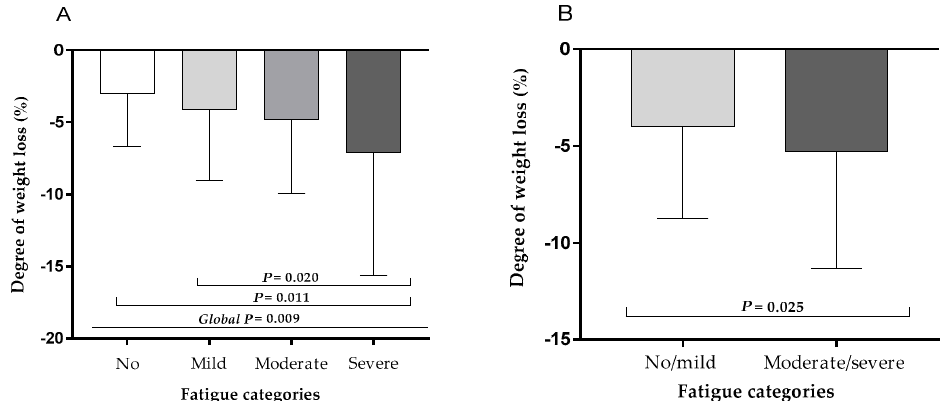
Figure 2. Degree of self-reported weight loss in old patients stratified according to four fatigue categories ( A ) as well as two fatigue categories ( B ) at hospital discharge. Column plots represent mean and SD maximum values.